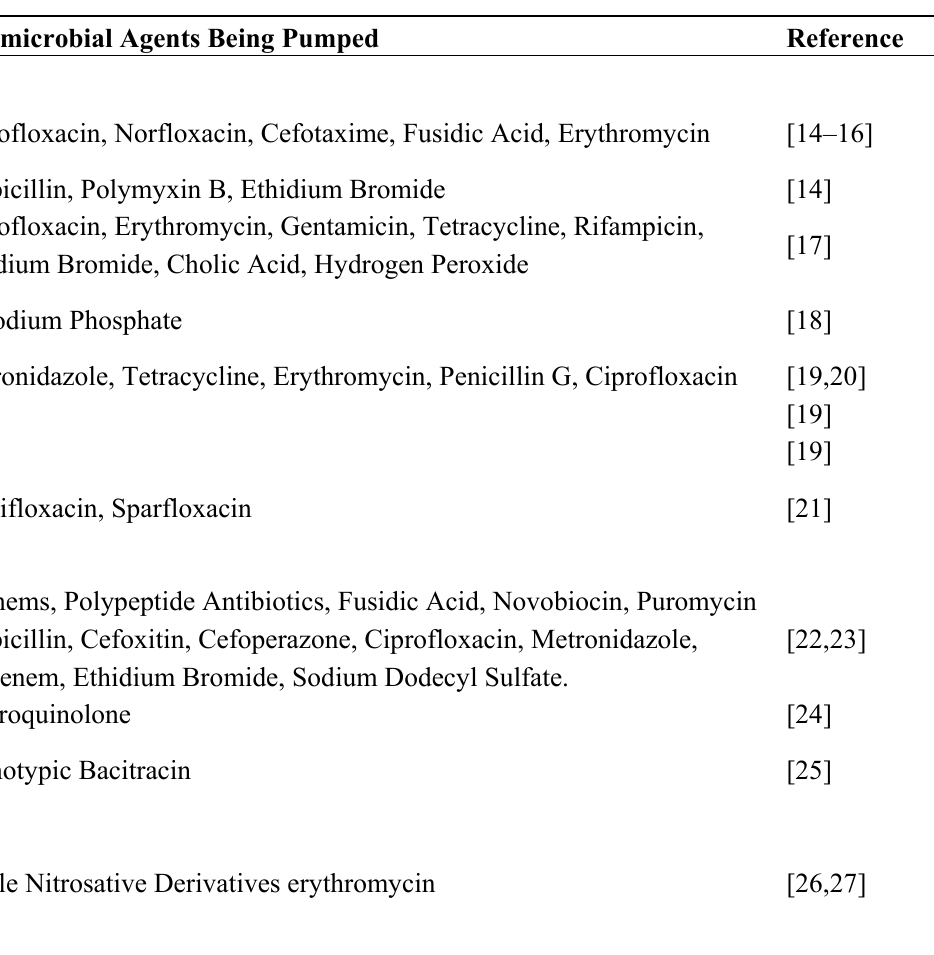
Table 1. A summary of the distribution, substrate spectrum, and regulation of bacterial efflux systems in microaerobic or anaerobic